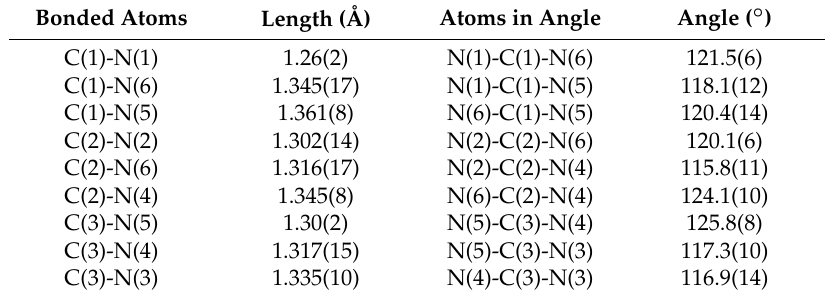
Table A1. Selected bond lengths and angles for melamine at 36.21(5) GPa (2015_10). Amino C-N-H angles are set to 120 ◦ by the AFIX hydrogen bond